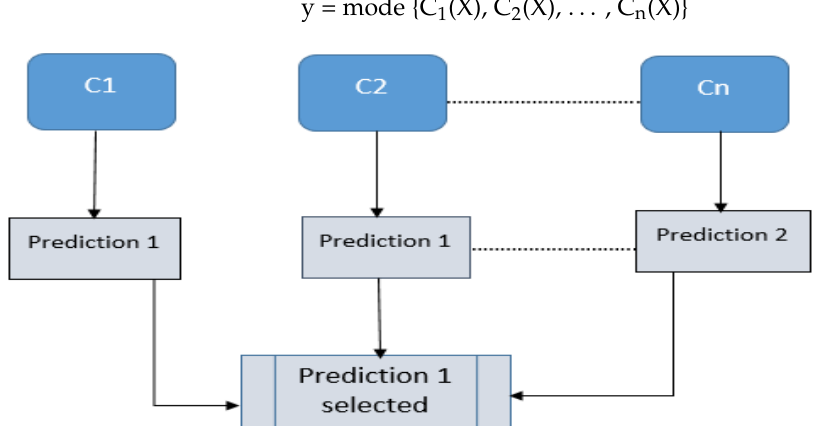
Figure 2. Architecture of ensemble hard voting classifier.